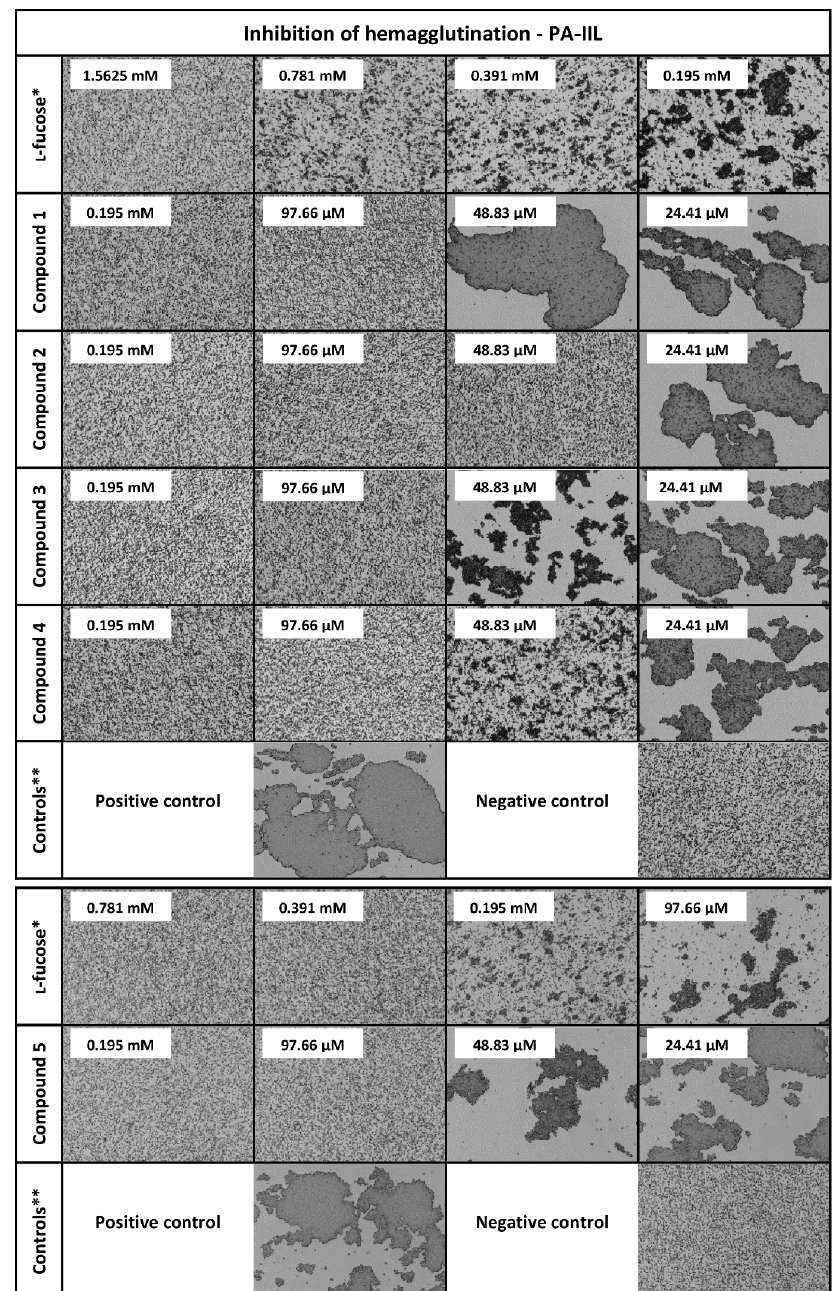
Figure 2. Influence of l -fucose, compounds 1 , 2 , 3 , 4 , and 5 , on hemagglutination caused by lectin PA-IIL. Used as an illustrative example of the data (images) acquired by a hemagglutination inhibition assay with microscope detection. The images for lectins AFL, RSL, AAL, AOL, and BC2L-C are included in the supplementary material. * Standard. Standard experiment was done anew for every used batch of protein or red blood cells. ** Controls were done anew for every used batch of protein or red blood cells. Positive control: experiment without any inhibitor. Negative control: experiment without lectin